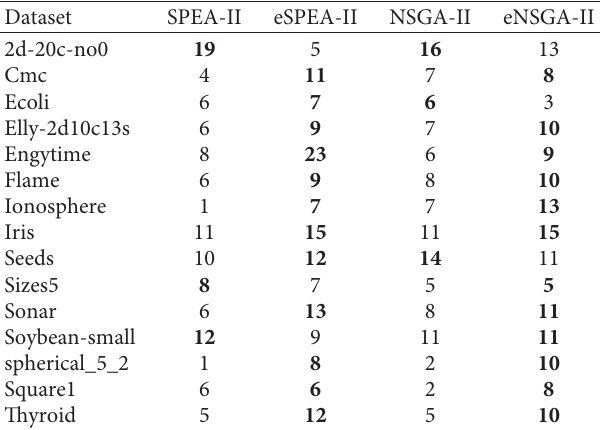
Table 5: The ONVG metric of the obtained Pareto-fronts by the competing algorithms from the combined pool of sets. Dataset